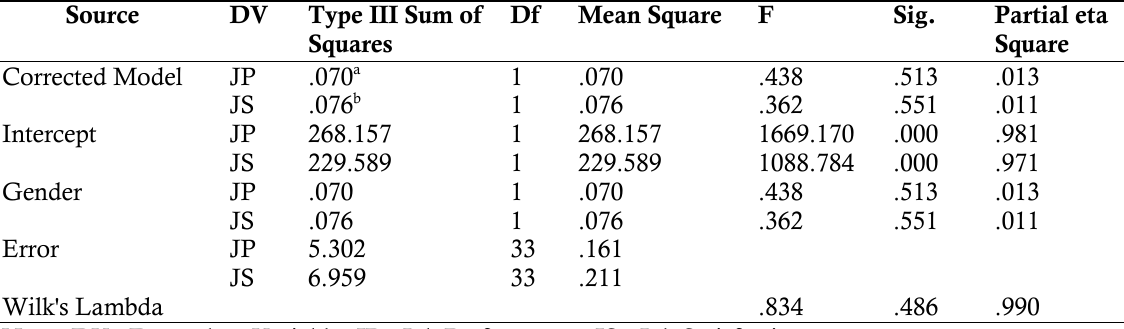
Table 3: Summary of MANOV A on the influence of gender in mentoring programme on job performance, and